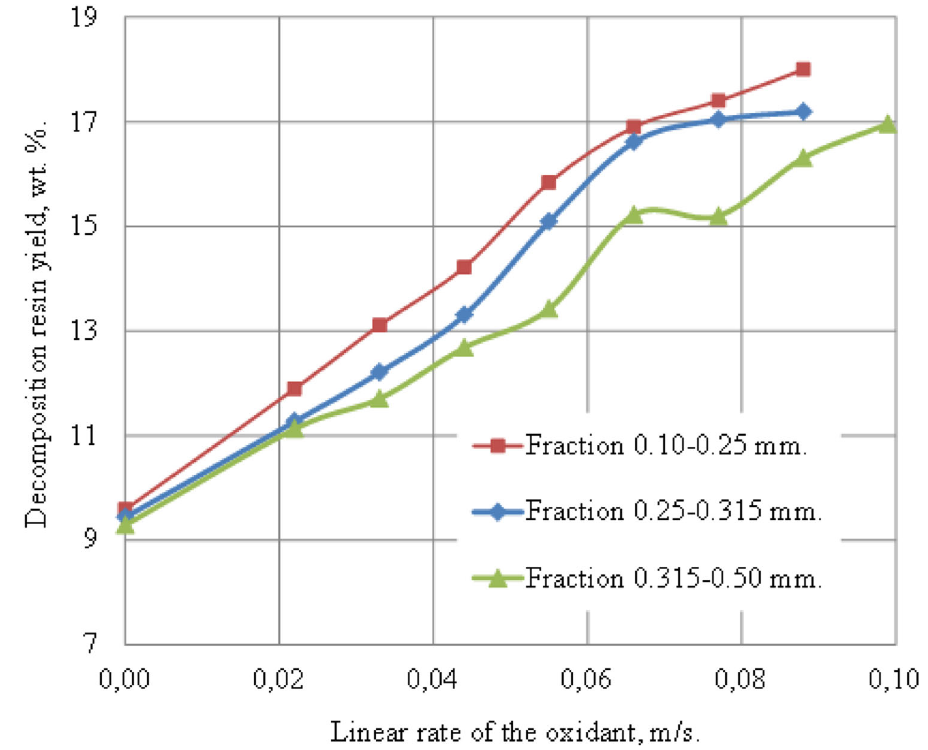
Fig. 3 Decomposition resin yield versus OLV and coal particles’ size